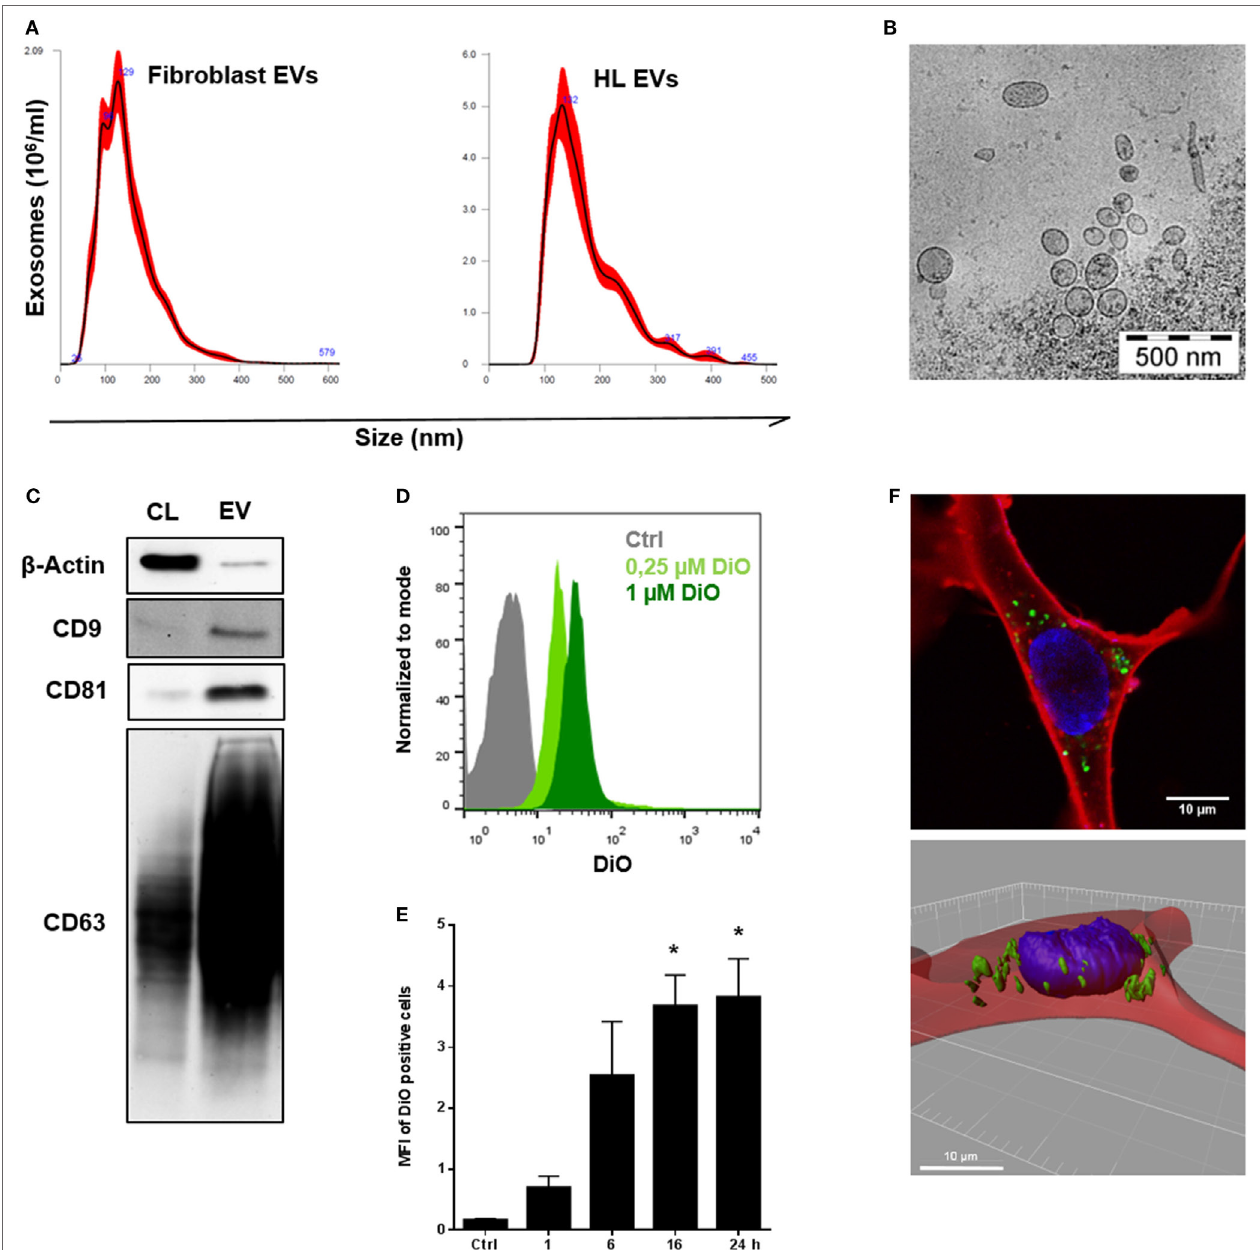
FigUre 1 | Characterization and internalization of tumor-derived extracellular vesicles (EVs) by fibroblast cells in vitro . (a) Size distribution of fibroblast EVs (performed once) or Hodgkin lymphoma (HL) EVs (representative experiment, n = 3), measured by nanoparticle tracking analysis. (B) Electron microscopic image of purified HL EVs ( n = 1). (c) Western blot analysis of exosome markers on HL-derived EVs. Cell lysate of HL cells served as control. Presented is one of three independent experiments. (D) Flow cytometry of beads coupled HL EVs which was collected from unstained cells (Ctrl) or from DiO-stained cells (0.25 or 1 µM DiO, n = 1). Normalization to mode: events are normalized in a scale with 100 being maximum (FlowJo v10). (e) Internalization of DiO-labeled HL EVs by fibroblasts assessed via flow cytometry at different time points as indicated. Fibroblast cells were incubated with 100 µg DiO + -EVs or DiO-negative EVs as negative control in the presence of EV-depleted medium. Statistical significance was calculated with one-way ANOVA and Tukey’s multiple comparisons test (mean + SEM of three biological replicates; * p ≥ 0.05). (F) Visualization of EV-uptake into fibroblasts via immunofluorescence: cytoplasm was stained with Cell Mask Deep Red (red), nuclei with Hoechst and HL-derived EVs with DiO (green). Upper picture shows a recipient cell with internalized HL EVs. Bottom picture depicts a three-dimensional